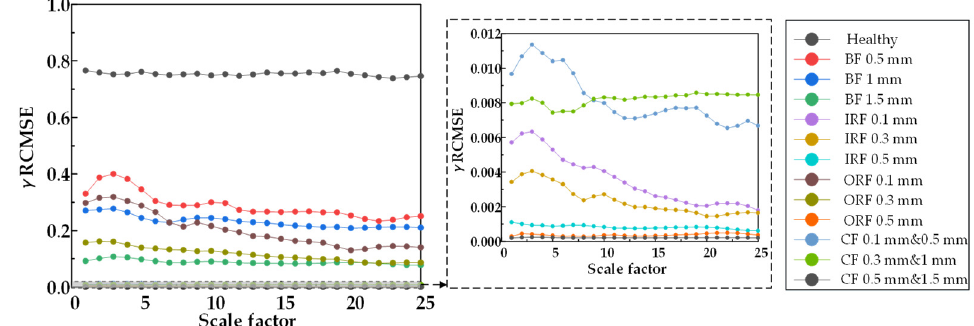
Figure 28. β RCMDE entropy values of 25 scale factors under different damage degrees.